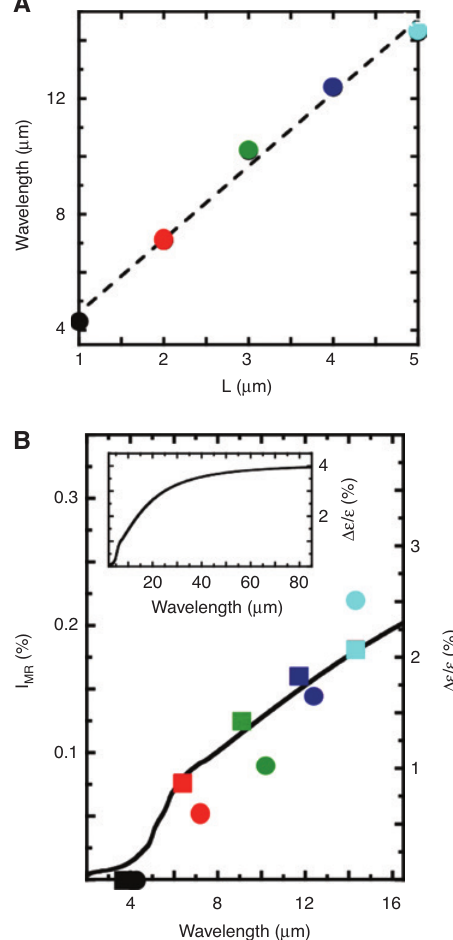
Figure 4: Wavelength dependence of magnetic modulation, with predicted continuous increase up to 90 microns. (A) The position of the resonances for the different slit arrays studied in Figure 3 as a function of the slit length. (B) Amplitude of the experimental (dots) and theoretical, divided by 5, (squares) magnetic modulation (I ) of the slit resonance as a function of the MR slit resonance position. The black curve corresponds to the spectral dependence of the modulus of the relative magneto-induced variation of the dielectric constant, Δ ε / ε due to MRE. Inset: extrapolation of the spectral dependence, extended to 90 microns, of the ratio Δ ε / ε